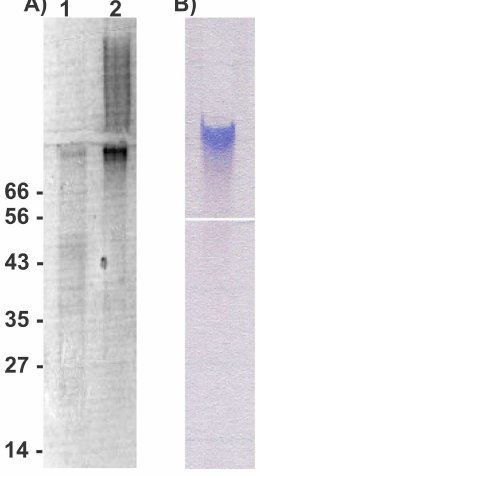
Figure 1. Polyacrylamide gel electrophoresis of Mp AFP-en- riched fractions. (A) The ice-bound fractions from one (lane 1) and two (lane 2) cycles of ice affinity purification were subjected to SDS- PAGE and stained with Coomassie blue. Mp AFP barely entered the resolving section of the gel. The locations of molecular mass markers (kDa) are indicated on the left. A right-pointing arrow indicates the junction between the stacking and resolving. (B) The ice-bound fraction from the second cycle of ice affinity purification was electrophoresed on a non-denaturing gel and stained with Stains-all. Mp AFP was still present within the stacking section of the gel when the bromophenol blue marker had reached the bottom of the separating gel. A left- pointing arrow indicates the junction between the stacking and resolving gels.